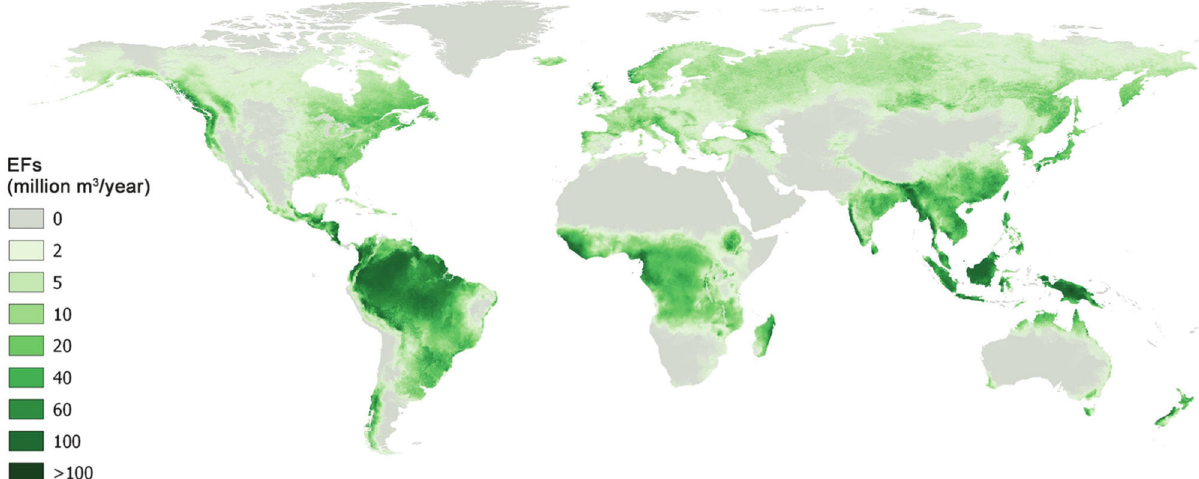
Environmental flows (EF) based on the values calculated in GEFIS (http:// gef.iwmi.org/) and adjusted to the total renewable water resources estimated with GlobWat. Geographic projection. Resolution 5 arc-minutes (approximately 10 km at the